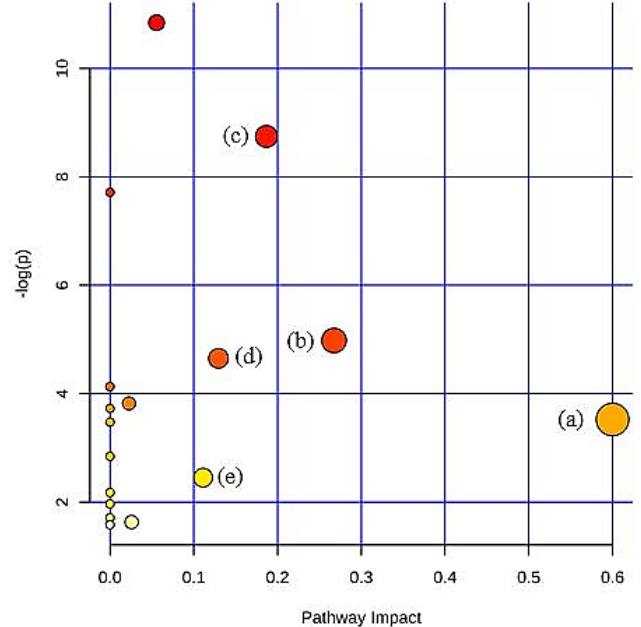
Figure 3. Pathways analysis ( a ) Synthesis and degradation of ketone bodies; ( b ) Pyruvate metabolism;